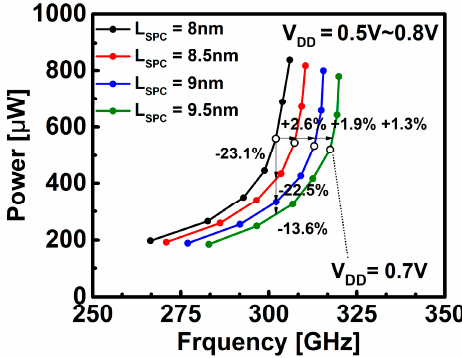
Figure 7. Power versus frequency for DG WS 2 -FET according to L SPC .